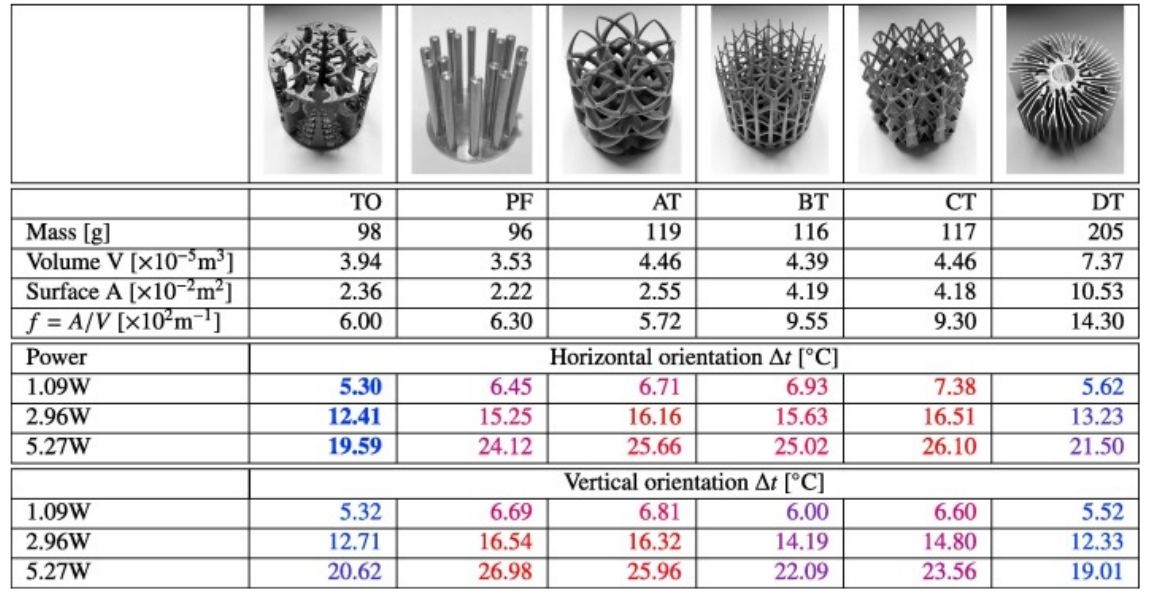
Figure 6. Topology optimized additively manufactured heat sink compared to conventional designs [60].